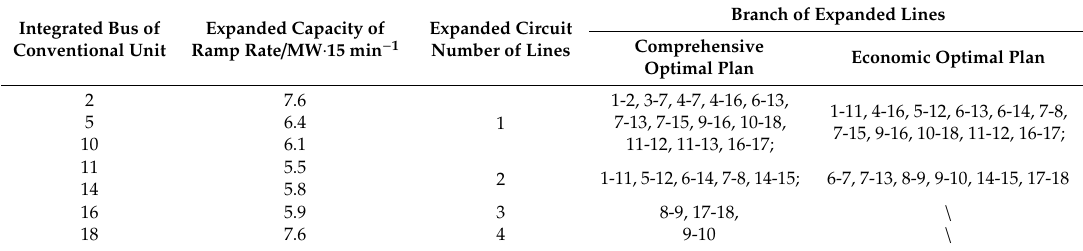
Table 1. Optimal adaptable source-grid planning scheme.